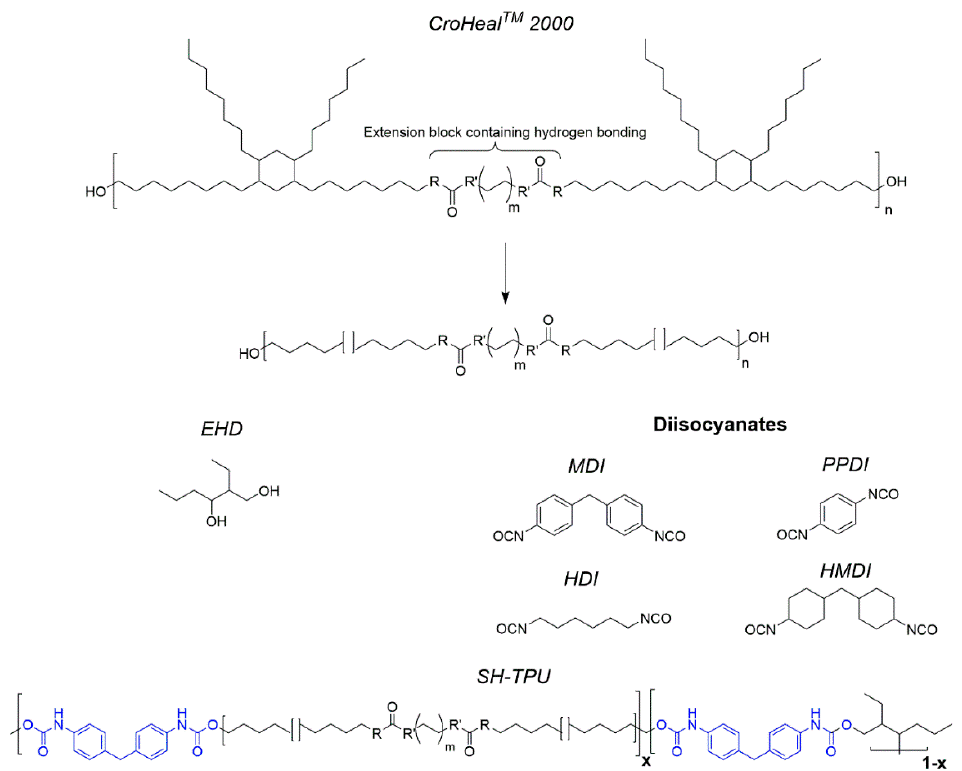
Figure 1. Chemical structure of CroHeal™ 2000, EHD and MDI and the molecular structure of the segmented SH-TPU used in this work with the soft block containing hydrogen bonds and aliphatic side branches, and the hard blocks containing aromatic interactions and hydrogen bonds.